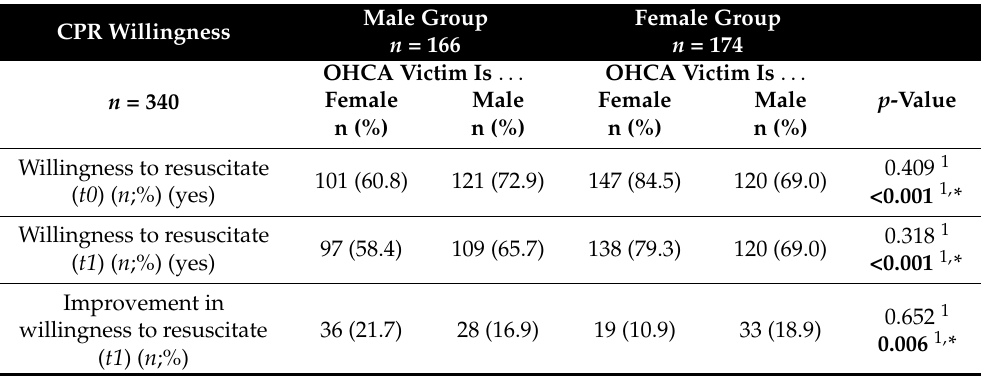
Table 3. Influence of OHCA victim’s gender characteristics on CPR willingness among male and female schoolchildren before and after CPR